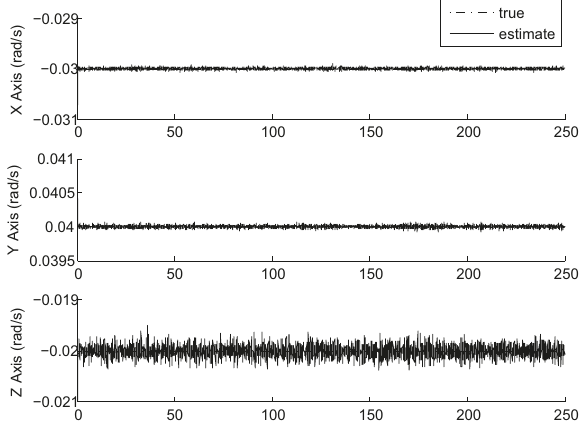
Figure 7. Angular velocity estimation results in simulation.